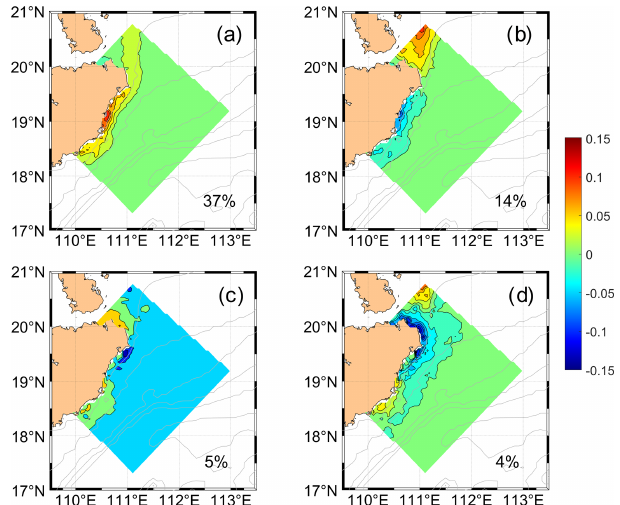
Figure 6. Spatial distributions of the first four EOFs for the Chl a concentration. The variance explained by each mode is